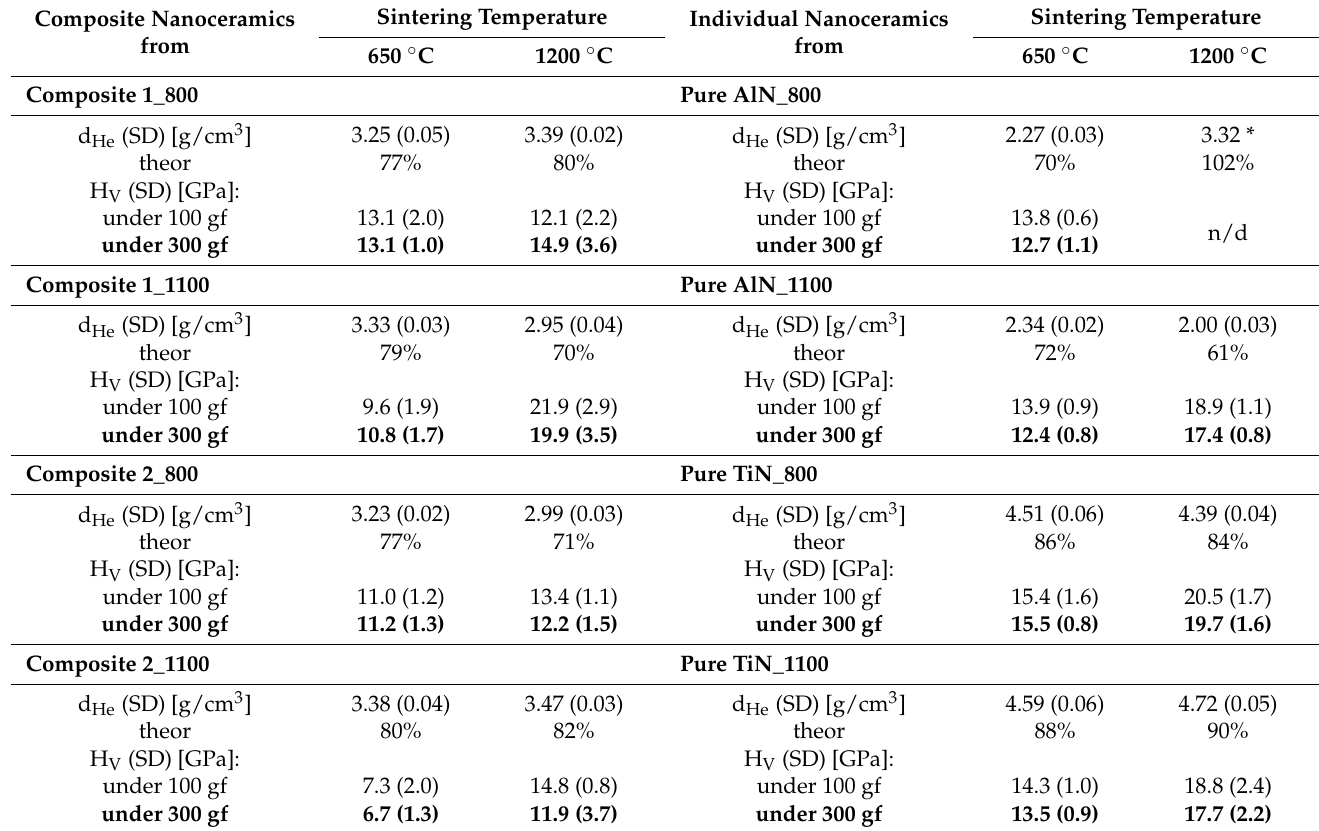
Table 3. Vicker’s hardness, H v (100 and 300 g-force loads) and helium density, d He data for composite and individual nitride nanoceramics in the system TiN-AlN. Percentages shown in helium density data are calculated with respect to theoretical density of composite c-TiN:h-AlN = 1:1 (molar basis) or of pure nitride. * Nanoceramics of partially oxidized AlN powder. Composite Nanoceramics